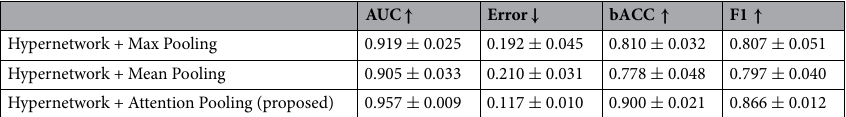
Table 5. Ablation study using different MIL methods on PANDA